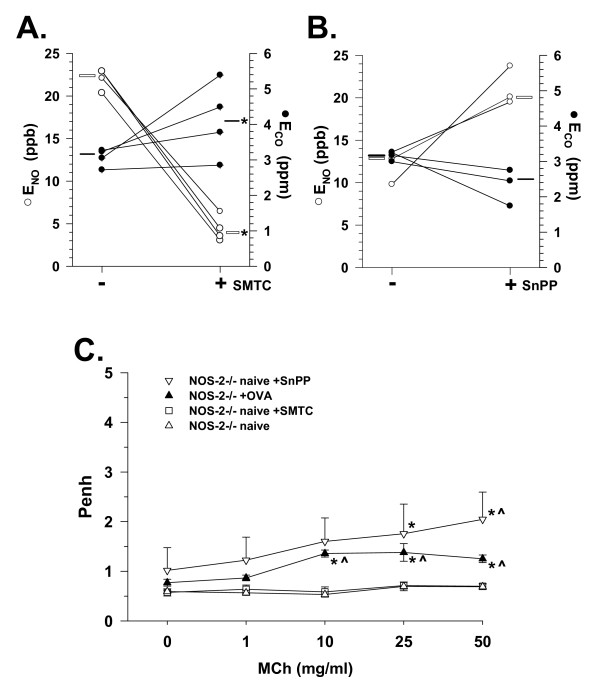
Modulation of ENO, ECO, and AR in NOS-2-/- mice. A. Changes in exhaled NO (ENO; open circle) and CO (ECO; filled circle) in NOS-2-/- mice (n = 4) 48 hr. after administration of S-methyl-L-thiocitrulline (SMTC). Open bar indicates median ENO value, black bar indicates median ECO value; *P < 0.05 vs. -SMTC. B. Changes in exhaled NO (ENO; open circle) and CO (ECO; filled circle) in NOS-2-/- mice (n = 3) 48 hr. after administration of tin protoporphyrin (SnPP). Symbols and bars as in panel A. C. Airway responses (Penh) to methacholine (MCh) aerosol in naïve NOS-2-/- mice treated with SMTC (open square n = 4) or SnPP (inverted open triangle; n = 3), and with allergic airway inflammation (+OVA, filled triangle, n = 8) as compared to naive NOS-2-/- mice with no treatment (open triangle; n = 8). *P < 0.05 vs. 0 mg/ml MCh, ^P < 0.05 vs. naive at same MCh concentration.